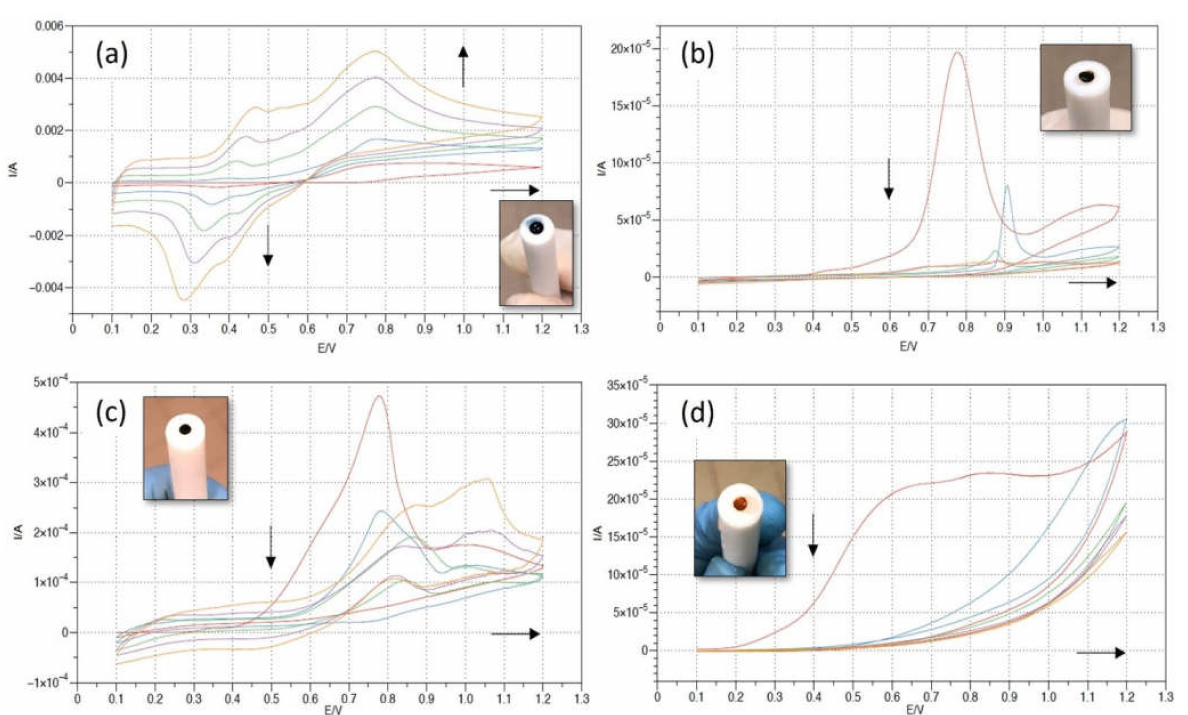
Figure 7. PANI potentiodynamic electropolymerization as a function of the electrolytic solution. Different electrolytes have been used to perform aniline electropolymerization, while all the other experimental parameters have been kept constant: electrochemical setup (Pt as CE, Ag/AgCl as Ref), electrochemical settings (0.1 V ÷ 1.2 V potential window, 0.1 V/s scan rate), substrate (Metrohm Au rod electrode). ( a ) Electrolyte consisting of H 2 SO 4 (1 M), aniline (0.1 M). ( b ) Electrolyte: CH 3 COOH (40 mM), aniline (0.1 M). ( c ) Electrolyte: NaCl (0.1 M), aniline (0.1 M). ( d ) Electrolyte: NaOH (0.1 M), aniline (0.1